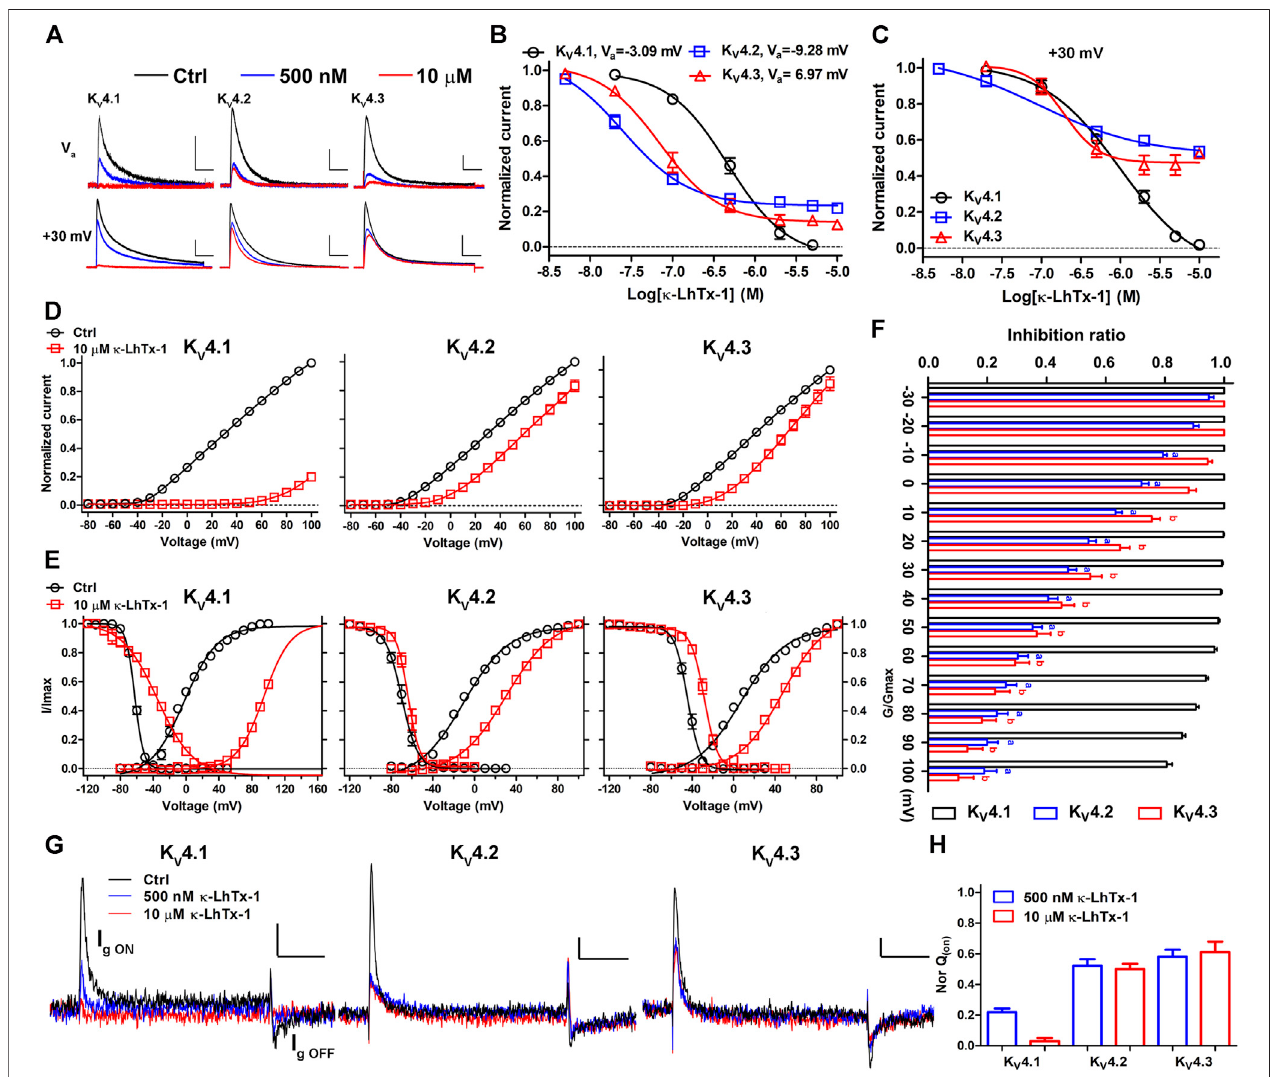
FIGURE 2 | κ -LhTx-1 inhibits K V 4 channels with different voltage-dependence. (A) , Representative traces showing the inhibition of K V 4 channels by κ -LhTx-1 at differentdepolarizingvoltages (Upper panel: test at V a voltage forK V 4.1, K V 4.2 and K V 4.3, respectively;Lower panel: test at +30 mV;n (cid:2) 5 – 6). Holding potential wasset to -80 mV, the V a value for each K V 4 subtype was as shown in (B) . Scale bars, 0.5 nA × 50 ms (Upper panel), 2 nA × 50 ms (Lower panel). (B, C) , The concentration- response curves of κ -LhTx-1 inhibiting K V 4 channels at their V a depolarization voltages (B) or +30 mV (C) . The IC 50 values in K V 4.1, K V 4.2 and K V 4.3 were determinedas0.51 ± 0.11 μ Mand0.87 ± 0.15 μ M,0.03 ± 0.01 μ Mand0.14 ± 0.05 μ M,0.06 ± 0.02 μ Mand0.16 ± 0.04 μ M,atV a voltageand+30 mV,respectively(n (cid:2) 5 – 6). (D) ,TheI-V relationshipsofK μ M κ -LhTx-1 treatment, currents atall voltages werenormalizedto V 4.1,K V 4.2and K V 4.3 channelsbefore(black) and after (red) 10 the control current (before toxin treatment) at +100 mV in each group (n (cid:2) 5 – 8). (E) , The steady-state activation/inactivation curves of K V 4.1, K V 4.2 and K V 4.3 channels before(black)andafter(red)10 μ M κ -LhTx-1treatment(n (cid:2) 5 – 10). (F) ,Theinhibitionratioof10 µM κ -LhTx-1onthecurrentsmediatedbyK V 4.1(black),K V 4.2(blue)and K V 4.3(red)atdifferentdepolarizingvoltages(n (cid:2) 5 – 8).a, p < 0.05whencomparingtheratioinK V 4.2withthatinK V 4.1;b, p < 0.05whencomparingtheratioinK V 4.3with